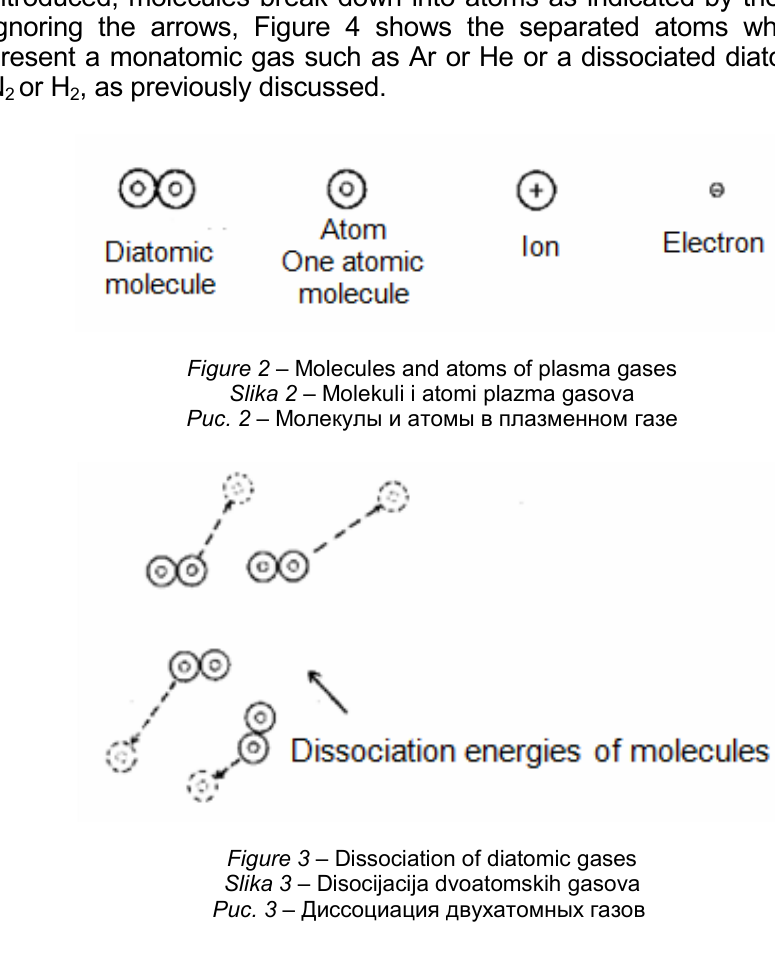
Рис . 3 – Диссоциация двухатомных